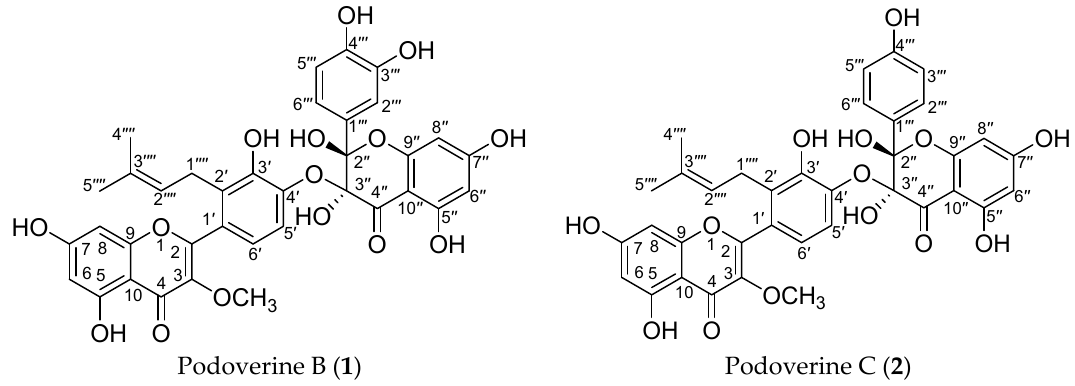
Figure 1. The chemical structures of two prenylated biflavonoids from S. emodi.